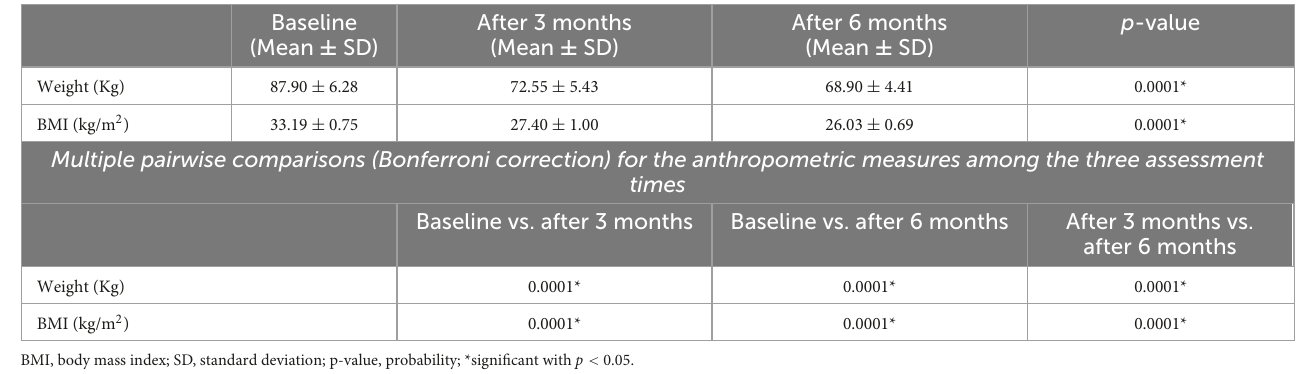
TABLE 2 Anthropometric measures among the three assessment